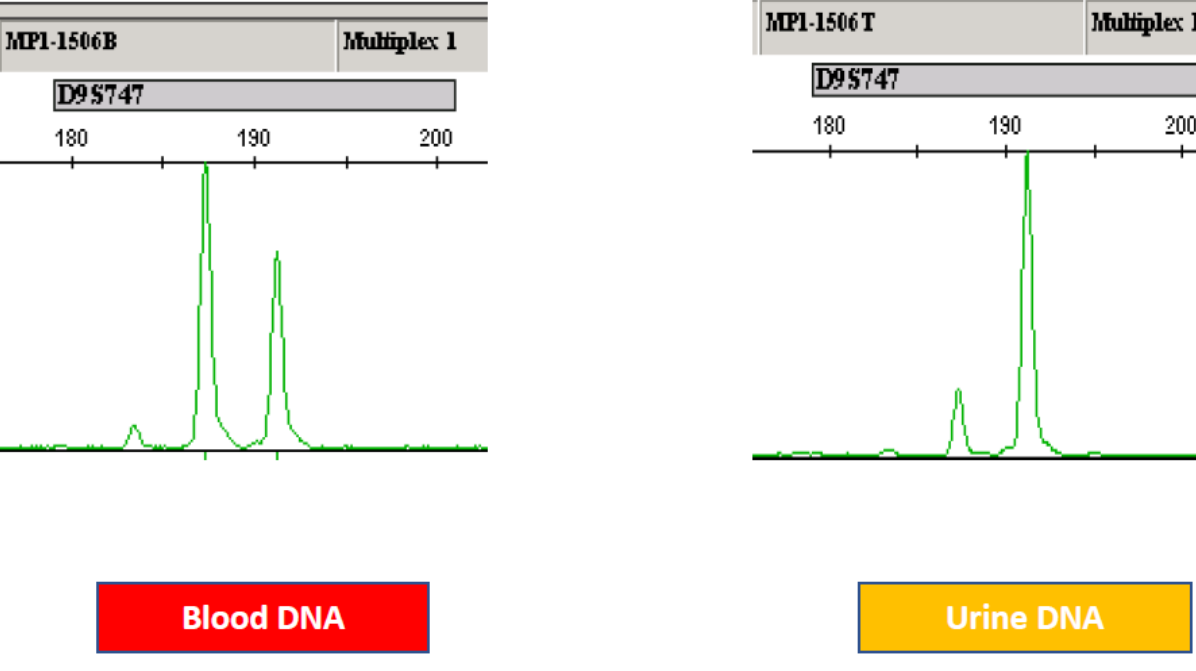
Figure 2. Example of MSA by genetic analyzer. In the upper panel, an MSI marker, M1506, is shown. In the left panel, a germ line MSI pattern is shown with two major peaks. In the right panel, both of the two peaks have been changed. These changes are detected by a series of algorithms in the ABI genetic analyzer.